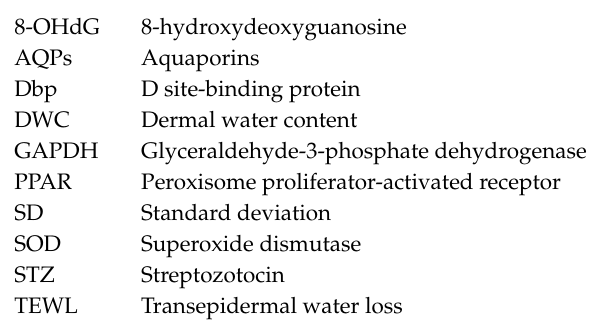
Figure S1: Water intake and urine volume, Figure S2: Expression levels of superoxide dismutase (Sod)1 and Sod2 in the